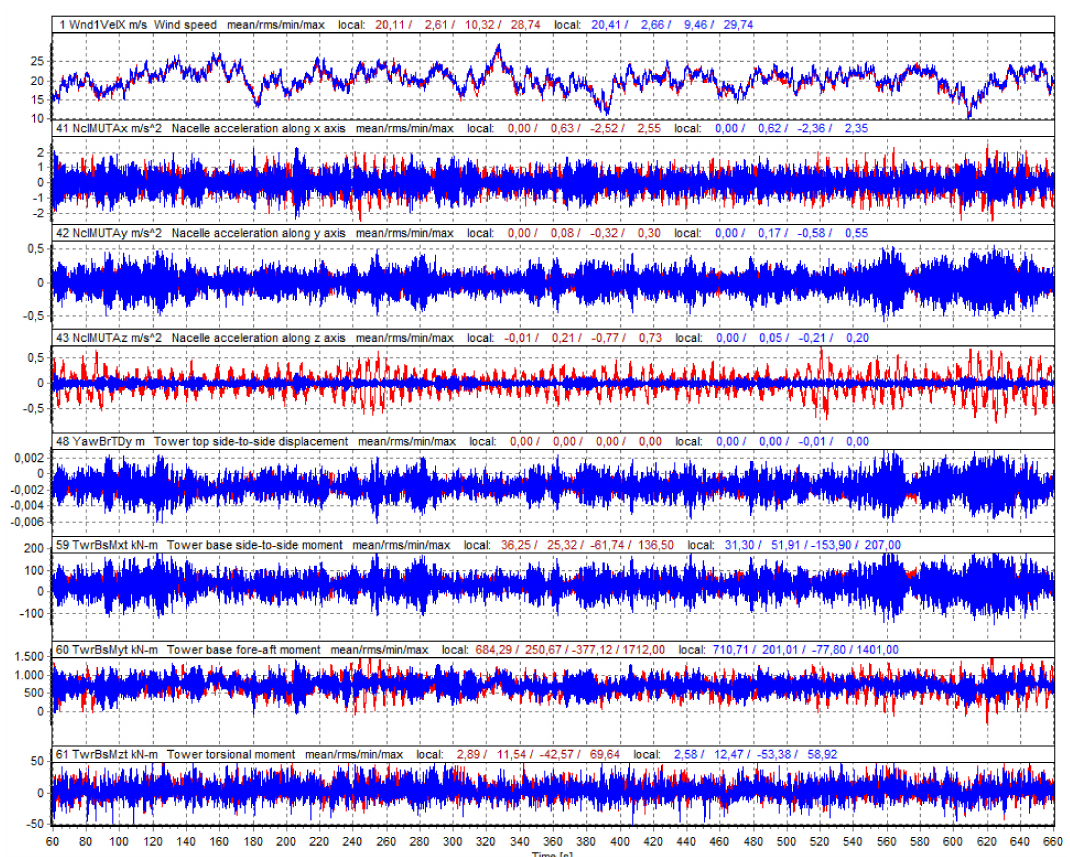
Figure 6. Comparison of time histories of wind speed, nacelle accelerations, tower top side-to-side displacement, tower base side-to-side moment, tower base fore-aft moment, and tower torsional moment between the onshore (shown in red) and offshore (shown in blue) wind turbine.